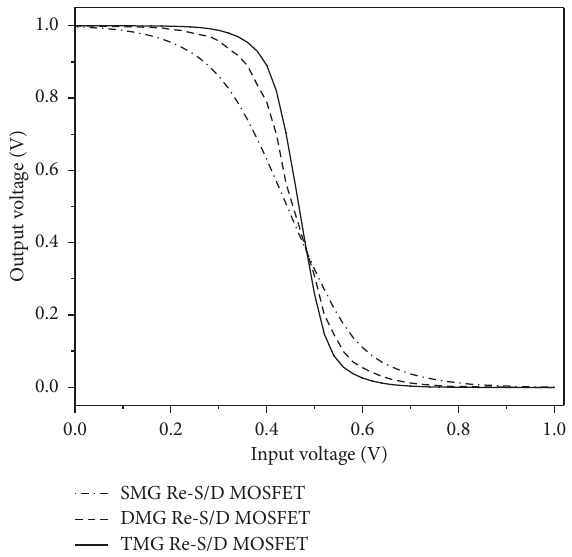
Figure 17: Voltage transfer characteristic curve of pseudo-NMOS for TMG, DMG, and SMG Re-S/D FD SOI